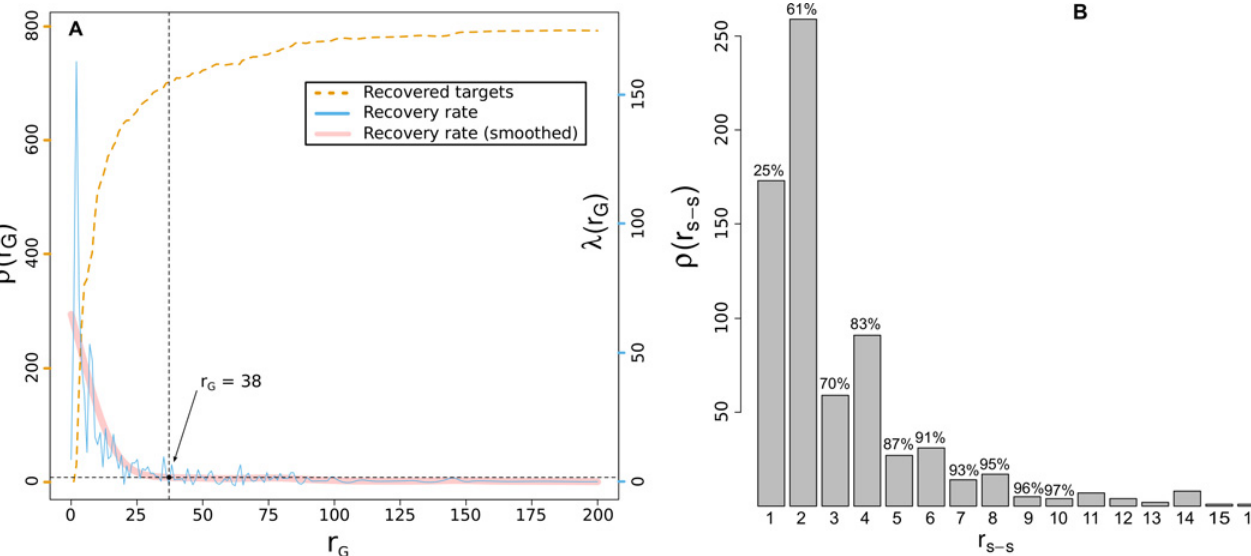
Fig 3. Performance at the task of recovery of the correct target for artificially orphaned compounds. A: Number of recovered proteins, ρ ( r G ) (left scale, blue line), and protein recovery rate λ ( r G ) (right scale, orange dashed line) as a function of global ranking threshold values, r G . The horizontal black dashed line represents 3 standard deviations (3 σ ) above the mean asymptotic noise level (see text). B : Distribution of species-specific ranking positions, r ss , for the 703 recovered true-targets which presented global ranking values lower than r * G = 38 estimated in panel A. Cumulative fraction of recovered targets is shown above